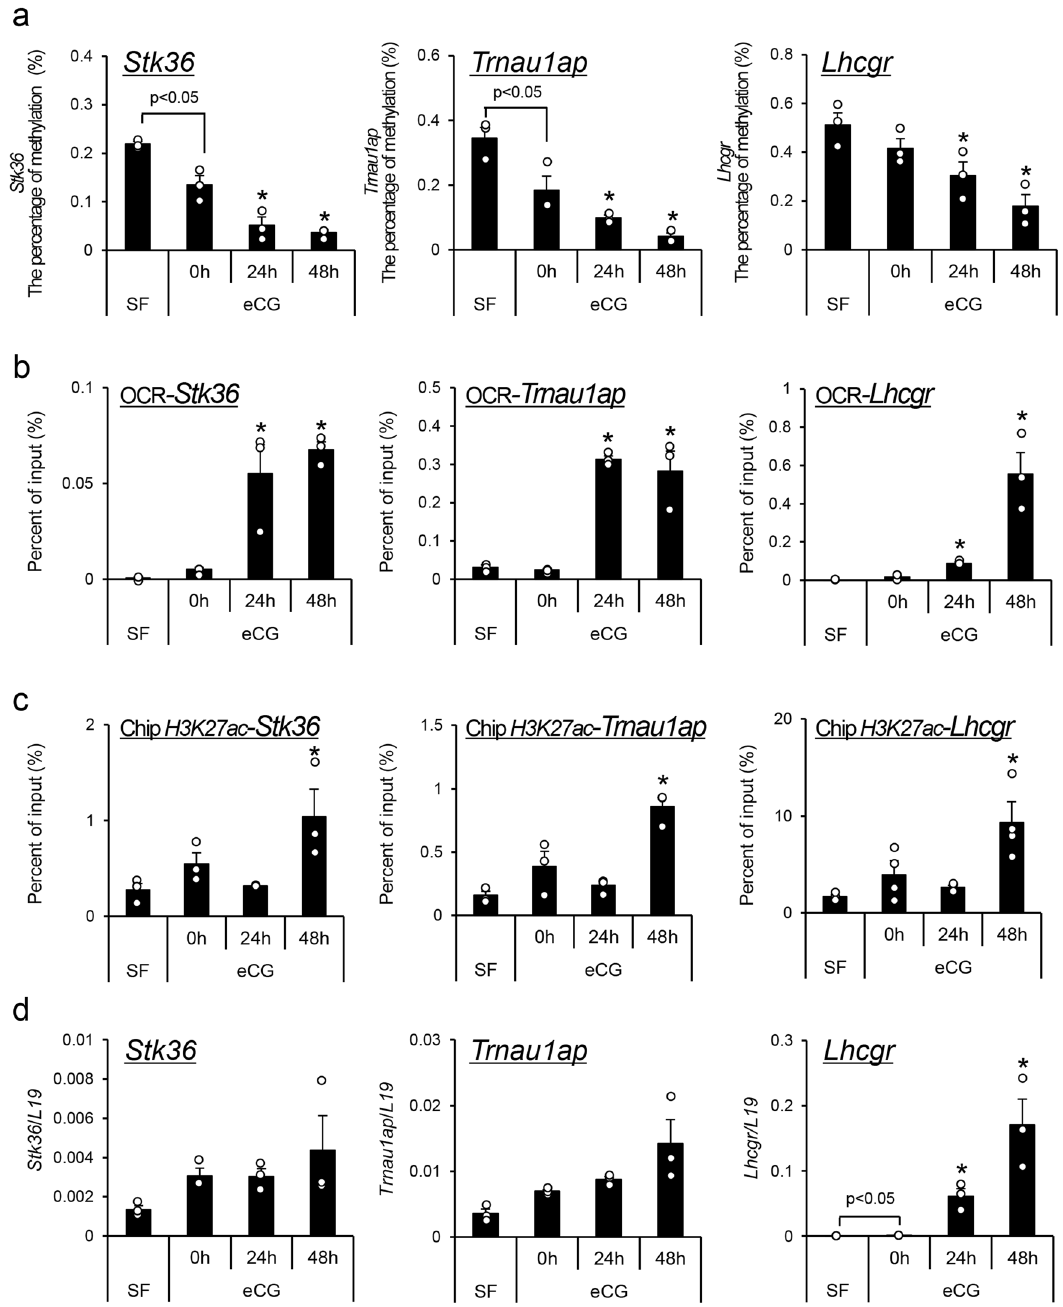
Fig. 4 Changes in epigenetic regulation of the demethylated genes Stk36 , Trnau1ap , and Lhcgr in granulosa cells during follicular development. a The temporal changes in methylation of promoter regions were analyzed by bisul fi te sequencing. Granulosa cells were collected from secondary follicles with multilayered granulosa cells or antral follicles (3-week mice not treated with eCG) before or after eCG injection. Values are represented as the mean ± SEM ( n = 3 biological replicates). Signi fi cant differences were observed between SF and eCG at 0 h ( p < 0.05). *Signi fi cant differences were induced by eCG injection compared with before eCG injection (0 h) ( p < 0.05). SF, secondary follicles. b , c The kinetic changes of the opened chromatin region (OCR) detected by FAIRE-qPCR ( b ) or the acetylated H3K27 detected by ChIP assay ( c ) in the promoter region of each gene in granulosa cells of secondary follicles with multilayered granulosa cells or antral follicles (3-week mice not treated with eCG) before or after eCG injection. The SF value was set as 1 and the data are expressed as fold induction. Values are represented as the mean ± SEM ( n = 3 biological replicates). Signi fi cant differences in percentage values were transformed into normally distributed numbers by angle transformation and then analyzed by one-way ANOVA. Tukey – Kramer was used as post hoc test. *Signi fi cant differences were induced by eCG injection compared with before eCG injection (0 h) ( p < 0.05). d Kinetic changes of the expression level of each gene in granulosa cells. Levels of mRNA were normalized to that of L19 . Values are represented as the mean ± SEM ( n = 3 biological replicates). Signi fi cant differences were observed between SF and eCG at 0 h ( p < 0.05). *Signi fi cant differences were induced by eCG injection compared with before eCG injection (0 h) ( p < 0.05).